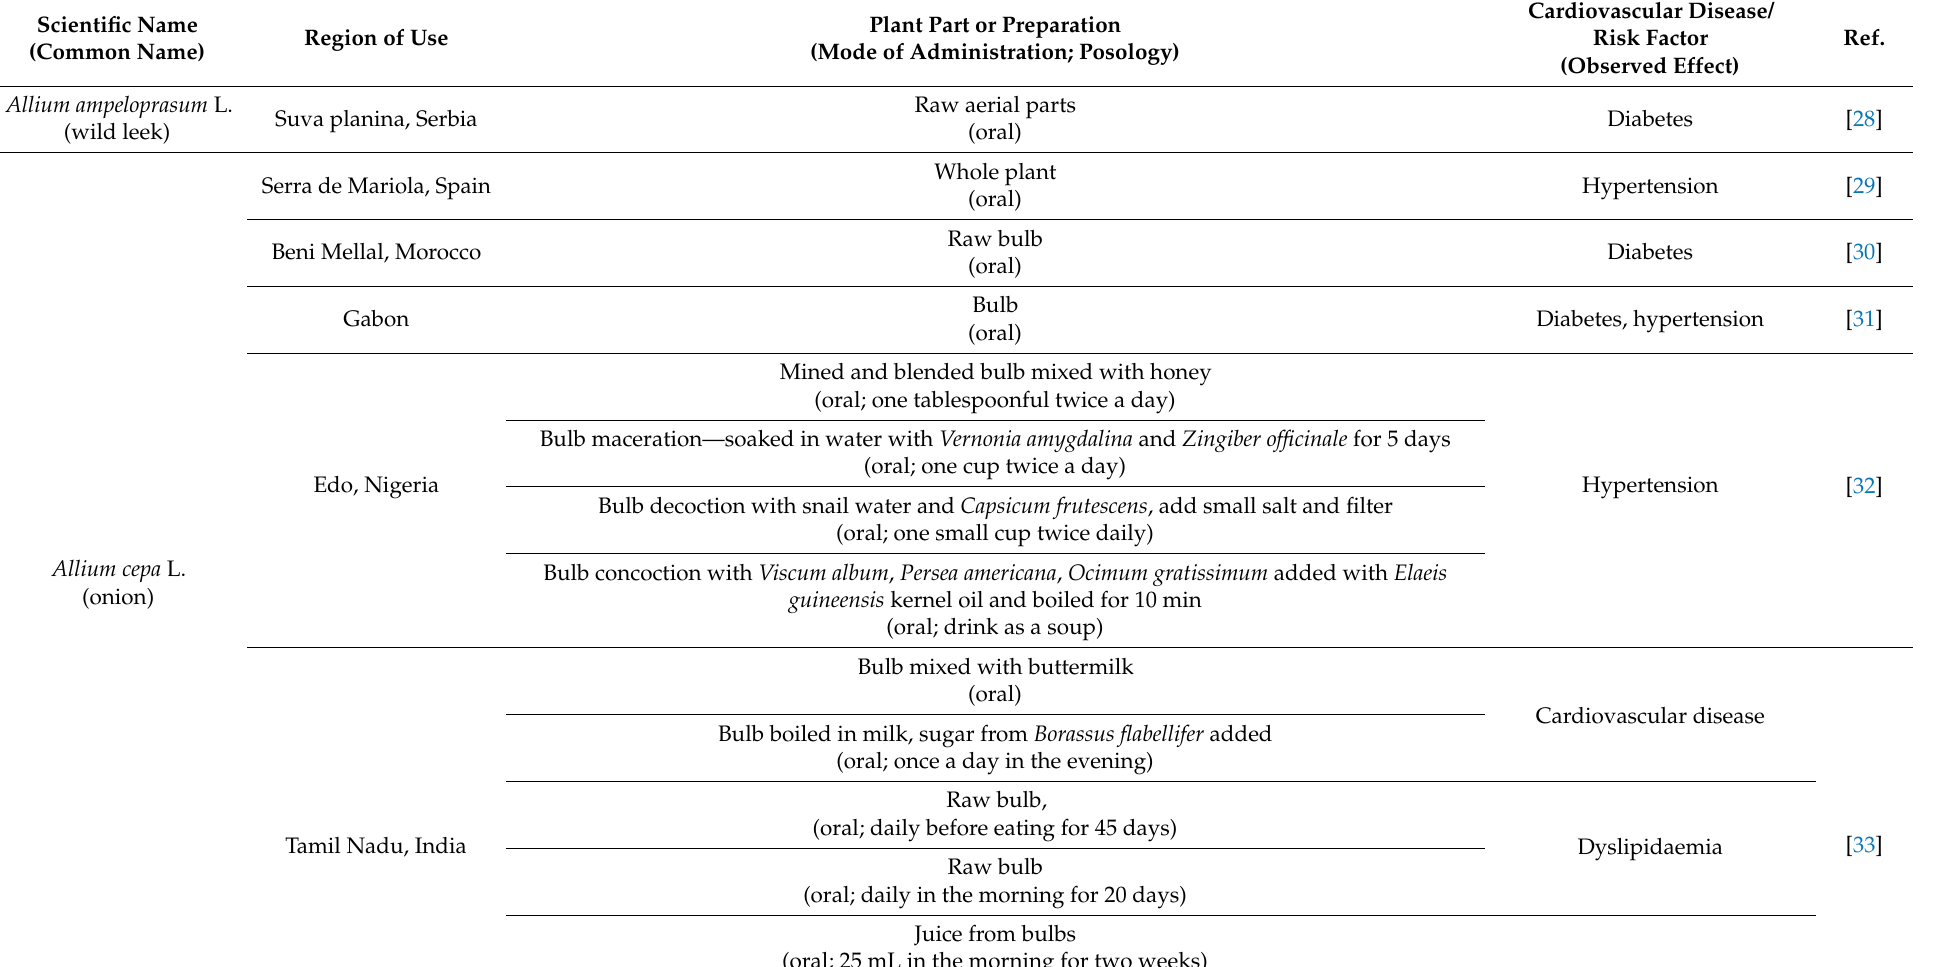
Table 1. Traditional uses ascribed to plants from the Allioideae